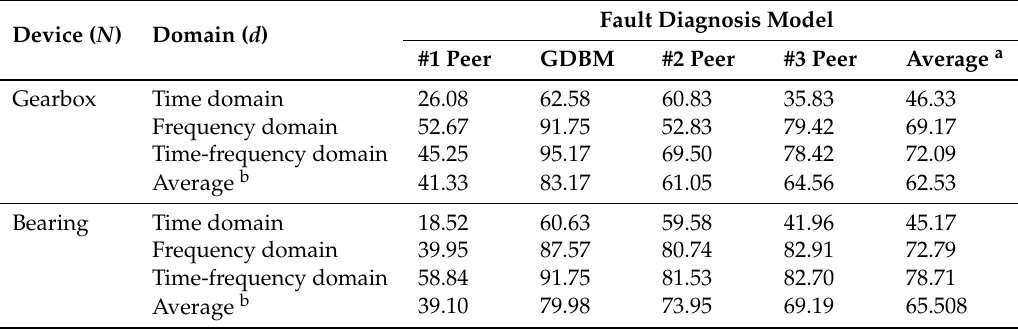
Table 2. Fault classification rates for the testing dataset (%), where N represents the device, d denotes the domain of the